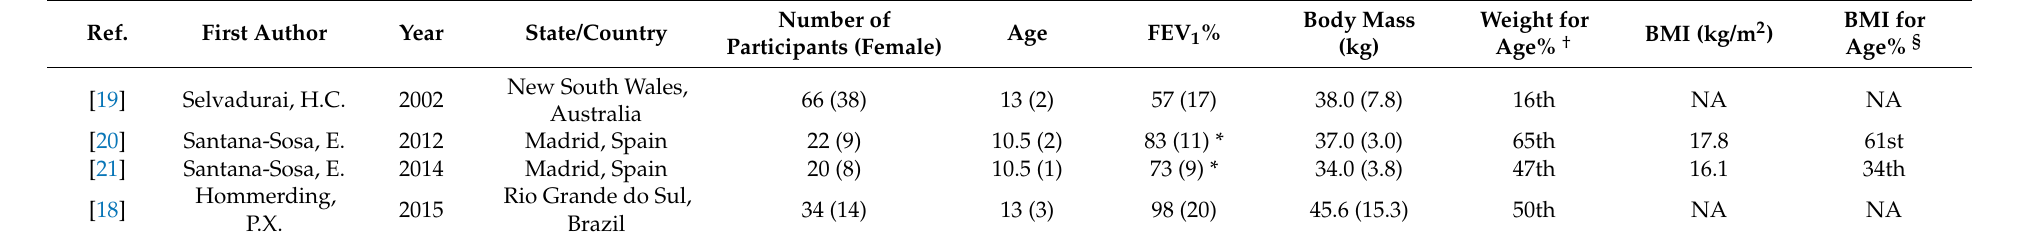
Table 2. Study site and baseline population demographics (sex, age, pulmonary function and nutritional status) for all participants. Ref.